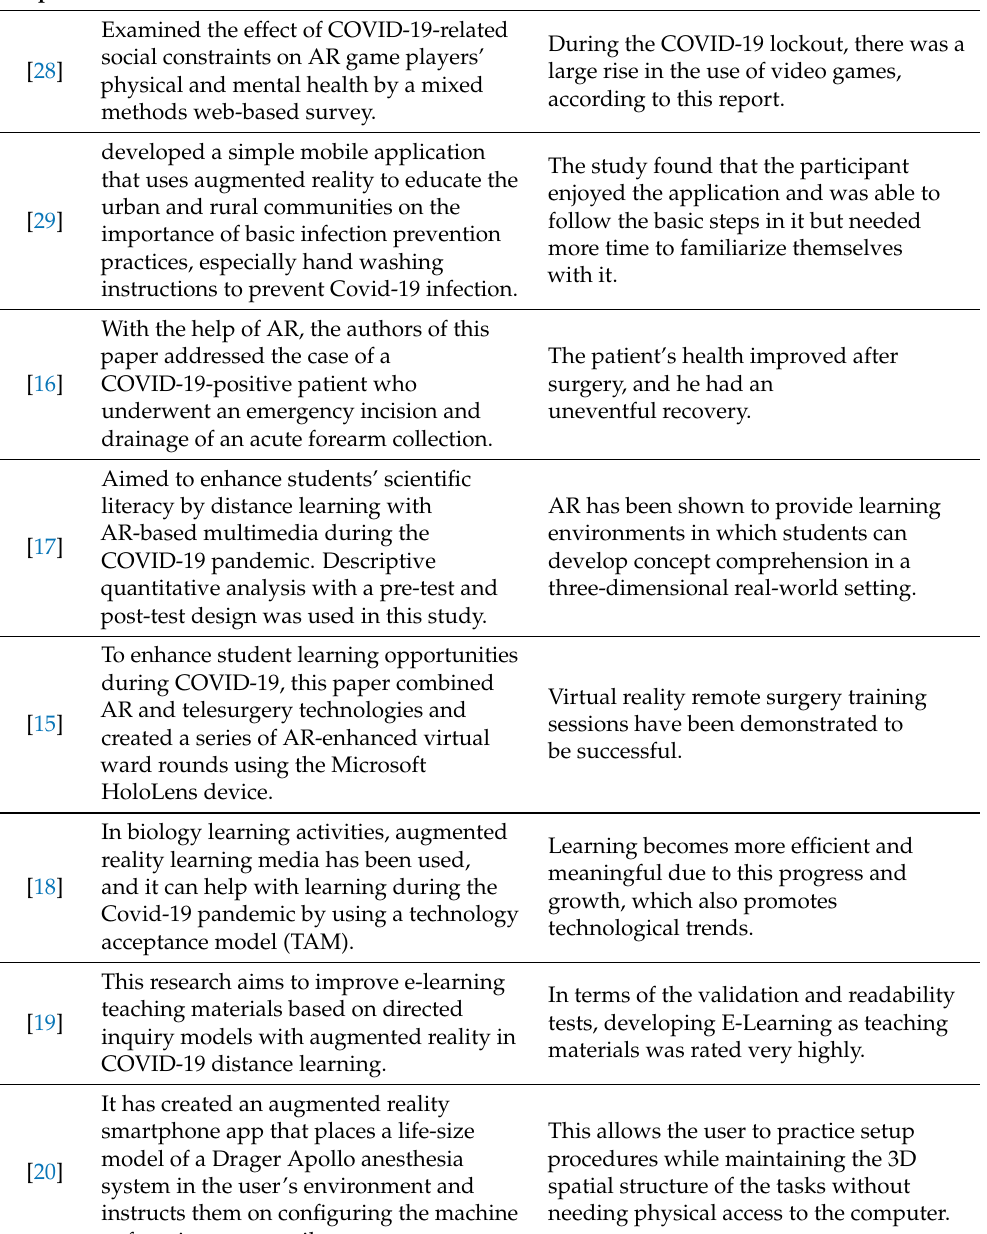
Table 1. Summary of procedure and outcomes on AR system with COVID-19 in the relevant